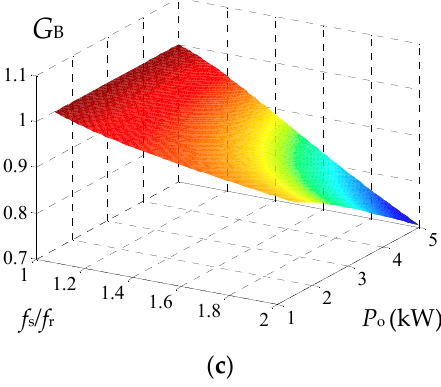
Figure 6. Voltage gain obtained by FHA model in backward mode: ( a ) whole frequency range; ( b ) f s < f r ; (c) f s ≥ f r .